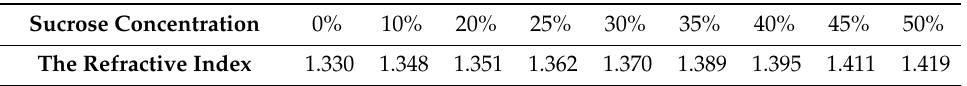
Table 2. The relationship between refractive index and concentration of refractive index matching solution (sucrose).